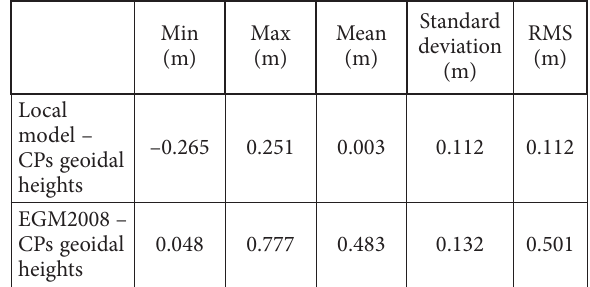
Table 5. Statistics of the differences between the local model and check point (CP) geoidal heights compared with those obtained for EGM2008